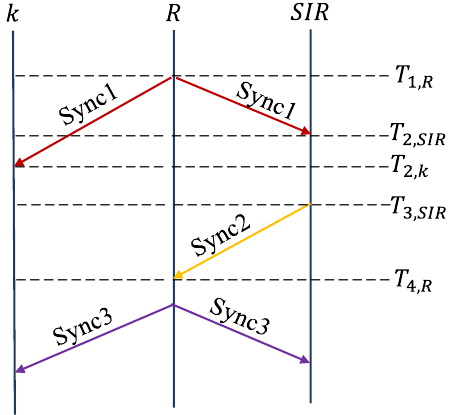
is the reference Figure 4. The synchronization process of LPSRS in a single broadcast domain. R is the reference 𝑅𝑅